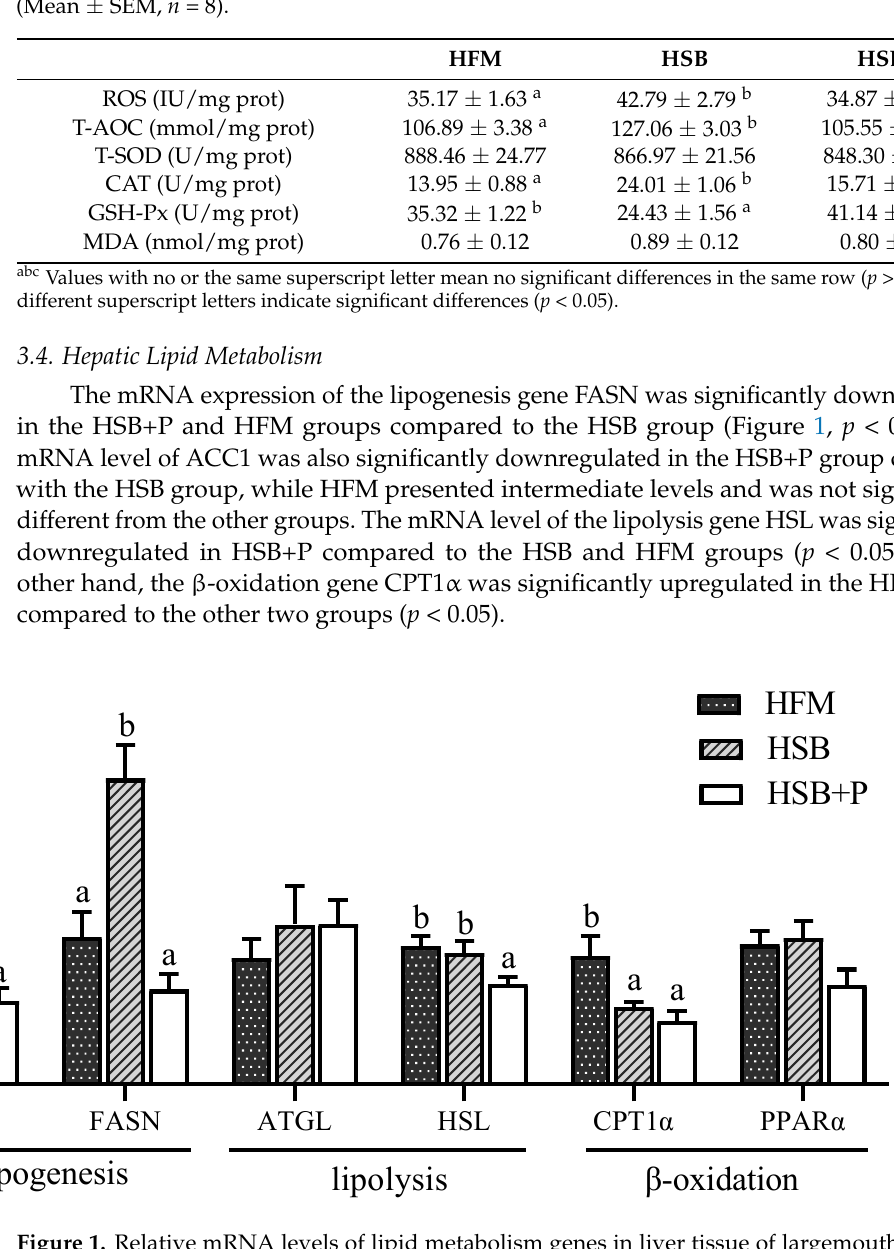
Figure 2. Histopathological examination under H&E (hematoxylin and eosin) staining of large- mouth bass liver samples (scale bar: 50 μ m, n = 12). The hepatocytes presented a normal shape and did not indicate fatty liver or other anomalies. 3.6. Western Blot for AKT-mTOR Pathway Protein expression levels of mTOR signaling pathways were measured in the large- mouth bass liver and results are shown in Figure 3. Compared to the HFM group, reduc- ing FM and increasing SBM contents in the diet significantly downregulated the phos- phorylation of AKT and mTOR. However, protein expression ratios of p-AKT to AKT and p-mTOR to mTOR were significantly increased after the addition of the phytogenic sup- plement ( p < 0.05).